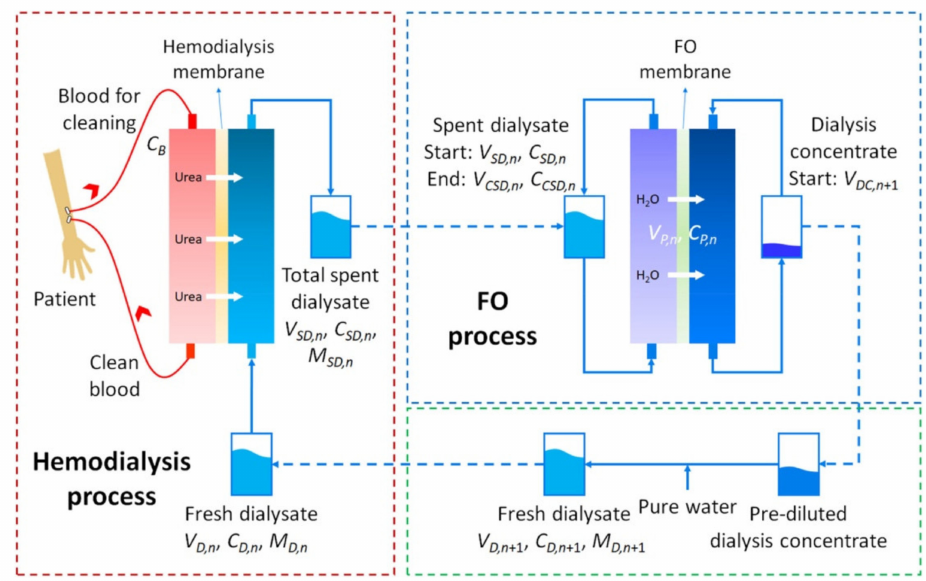
Figure 1. Scheme of the combination of the hemodialysis and spent dialysate recovery by osmotic dilution. A partial amount of water in the spent dialysate spontaneously moves toward the dialysis concentrate, as a consequence of the osmotic pressure gradient across the FO membrane. After FO, a certain amount of pure water is added to further dilute the dialysis concentrate. The dialysate without recovered water from the spent dialysate is used in the first hemodialysis session (reproduced with permission after